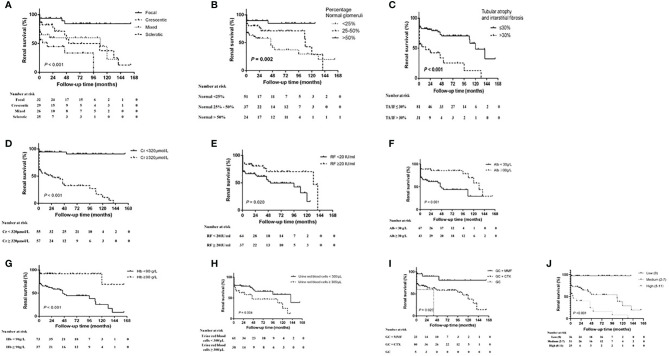
Kaplan–Meier renal survival curve for MPO-ANCA-GN and different risk factors. (A) histopathologic classification, (B) the percentage of normal glomeruli, (C) tubular atrophy and interstitial frosis, (D) serum creatinine (Cr) level, (E) rheumatoid factor (RF) level, (F) serum albumin (Alb) level, (G) hemoglobin (Hb) level, (H) urine red blood cell count, (I) treatment regimen and (J) Brix Renal Risk Score according to the risk group (low, 0 points; medium, 2–7 points; high, 8–11 points). CTX, cyclophosphamide; GC, glucocorticoid; MMF, mycophenolate mofetil.